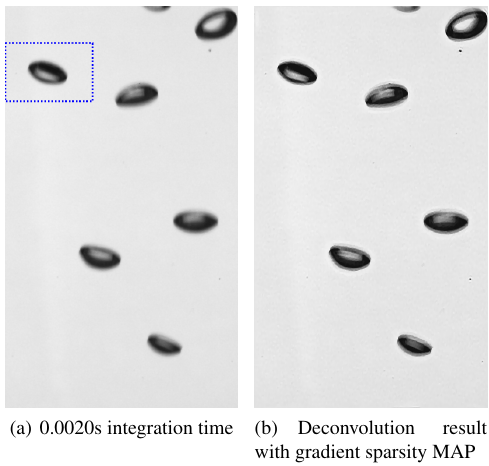
Figure 5: Medium motion blur image and gradient sparsity de- convolution. The dotted blue rectangle shows the cropped seg- ment of Figure 6.